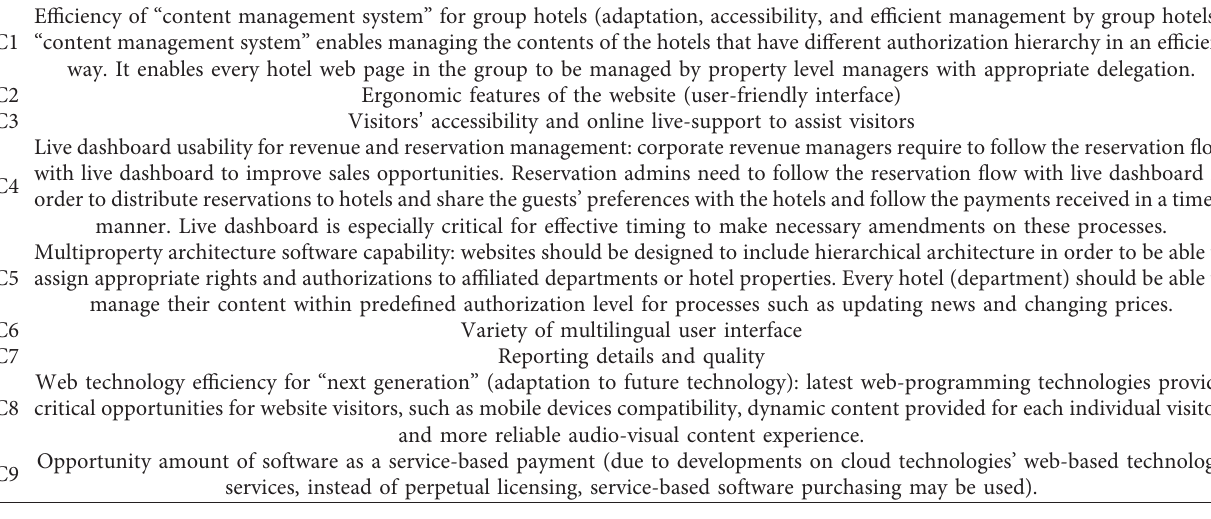
Table 4: Evaluation criteria for hotel website and digital solutions provider firms.